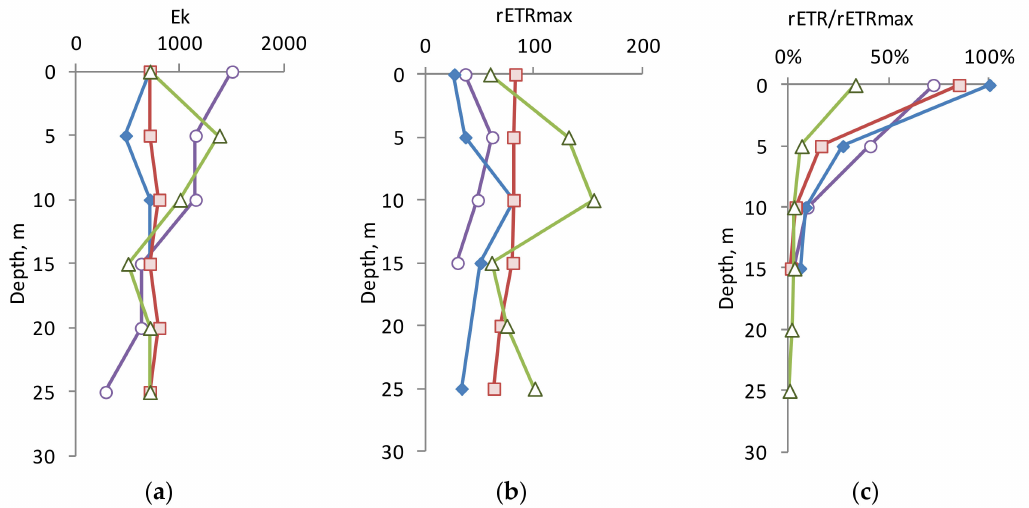
Figure 4. Vertical distribution of phytoplankton light adaptation parameters: ( a ) light saturation constant, E k , µ mol photons/m 2 per s, ( b ) maximum relative electron transport rate, rETR max , a.u. ( c ) ratio of relative electron transport rate at ambient light (rETR) to rETR max (rETR/rETR max ) for April (circles), June (rhombus), October (squares), and November